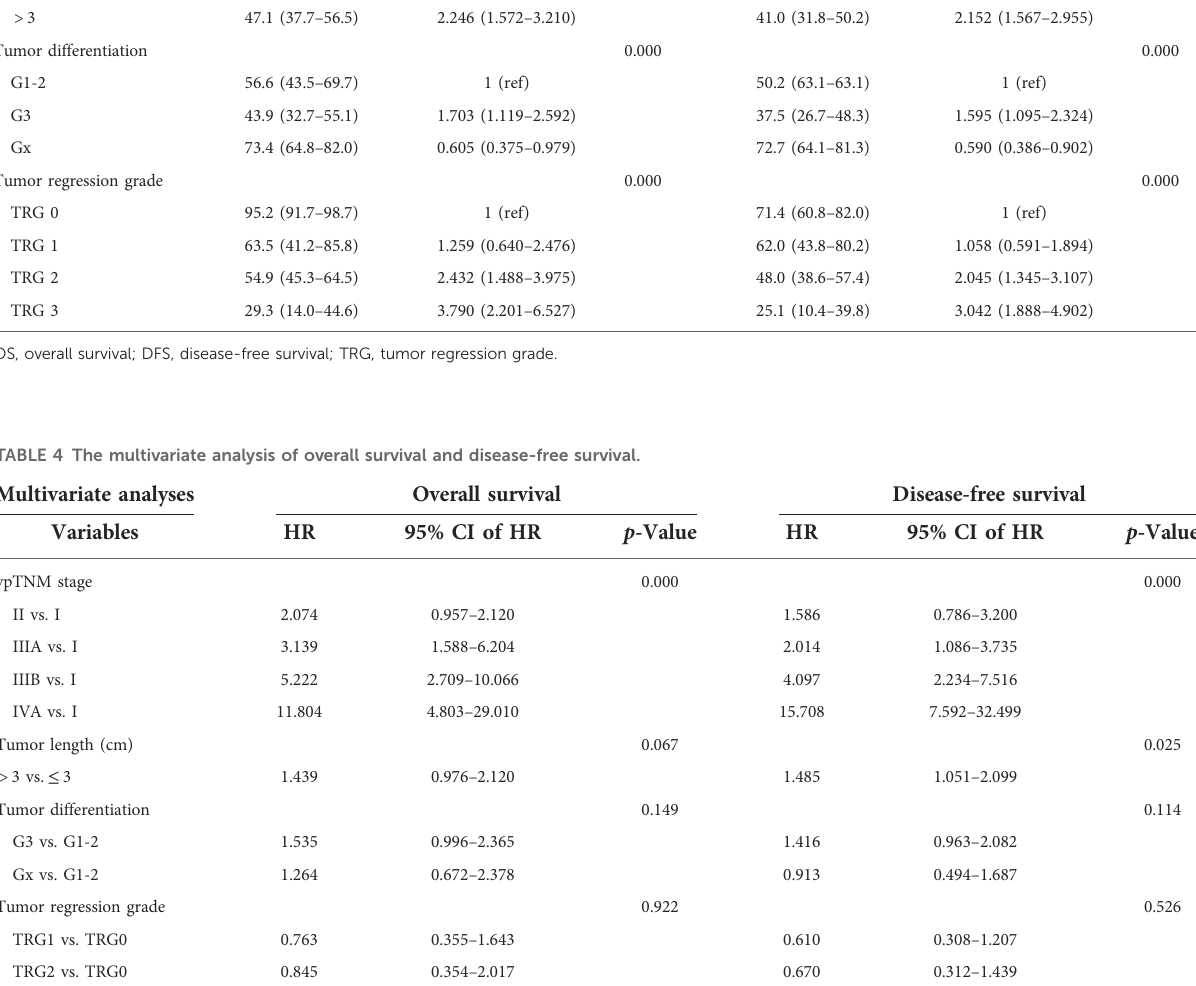
OS, overall survival; DFS, disease-free survival; TRG, tumor regression grade.